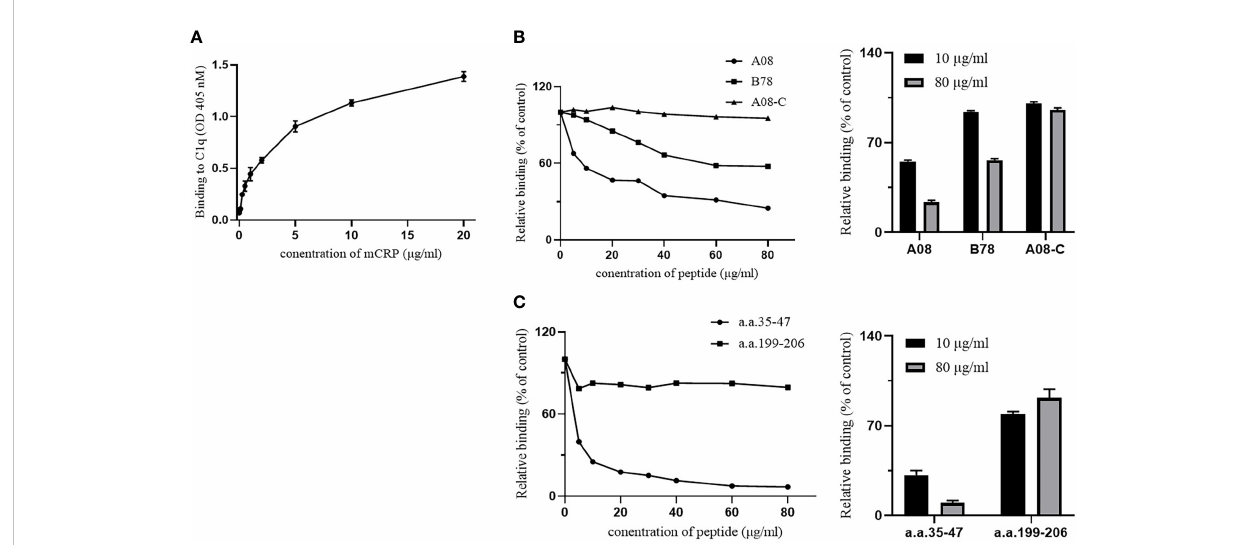
FIGURE 3 The binding epitopes of mCRP and C1q by ELISA. (A) C1q was immobilized on the ELISA plate, and then different concentrations of mCRP were added. The binding activity of mCRP to C1q was measured using mCRP-speci fi c antibody 3H12. As the concentration of mCRP increased, the absorbance increased and was dose-dependent. (B) Fix the urea-denatured mCRP on the microplate, and different concentrations of peptides A08, B78, and A08-C were added to the plate. The inhibition of binding of C1q to mCRP was inhibited by 80% when 80 m g/ml of A08 was added. (C) Fix C1q on the microplate, then different concentrations of peptides a.a.35-47 and a.a.199-206 were added to the plate. We observed that a.a.35-47 signi fi cantly inhibited the binding of mCRP to C1q, and it inhibited by 90% when added to 80 m g/ml of